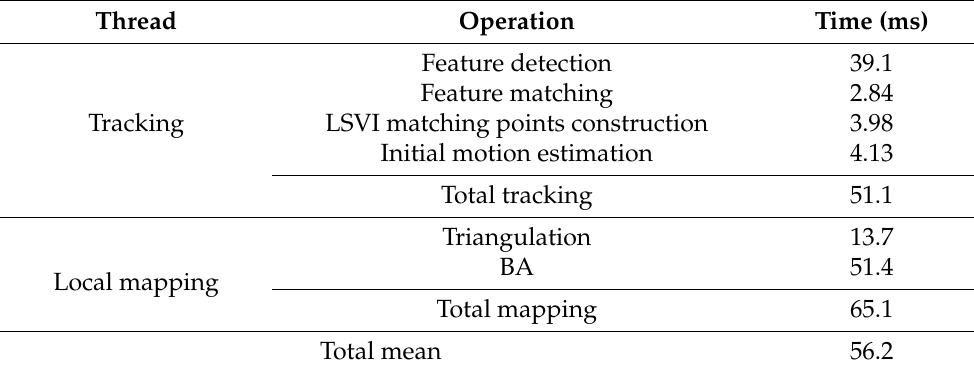
Table 2. Timing results for each thread on the simulation data